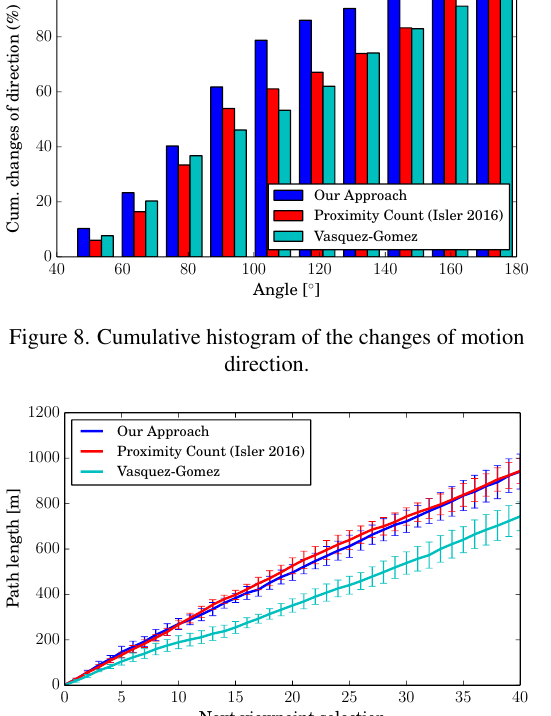
Figure 7. Total number of explored voxels in the map at each viewpoint.